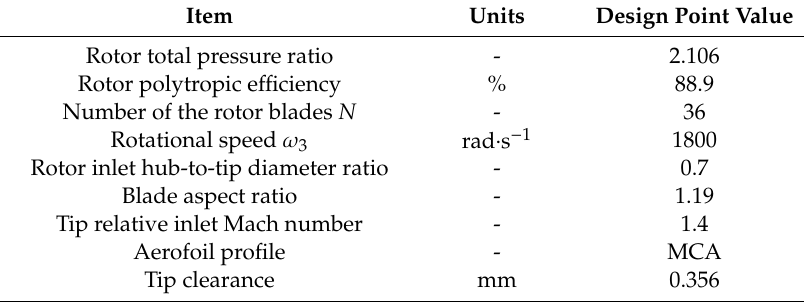
Table 1. Overall parameters of NASA rotor 37.